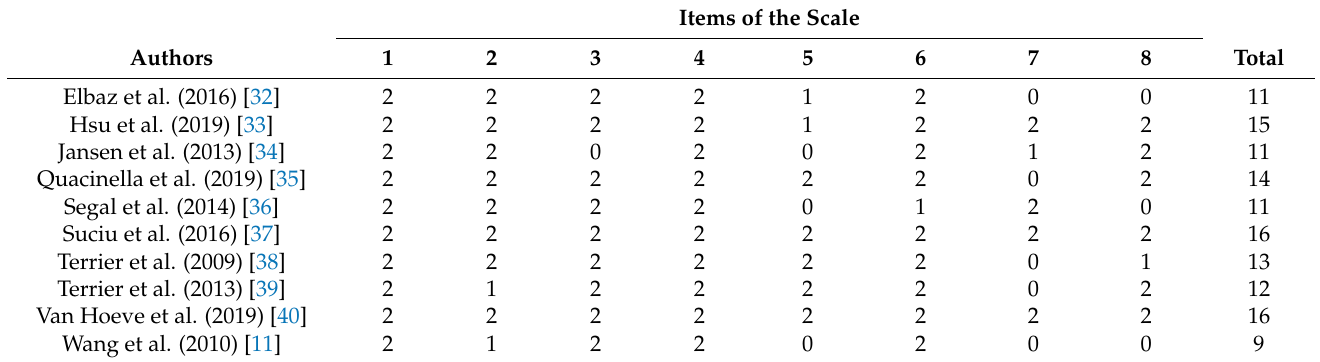
Table 1. Methodological quality using the MINORS scale for nonrandomized controlled trials. Items of the